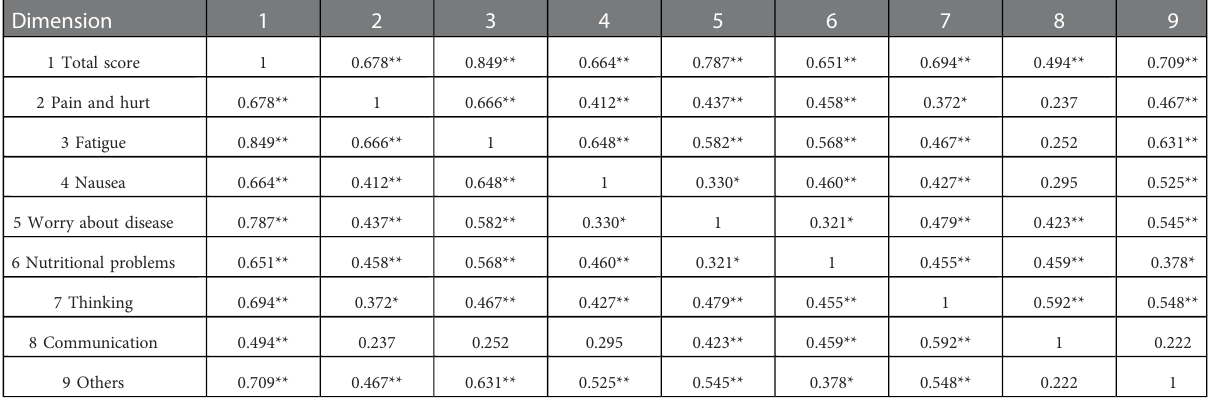
TABLE 7 Correlation between total score of the PedsQL ™ stem cell transplant module and each dimension for child self-report. Dimension